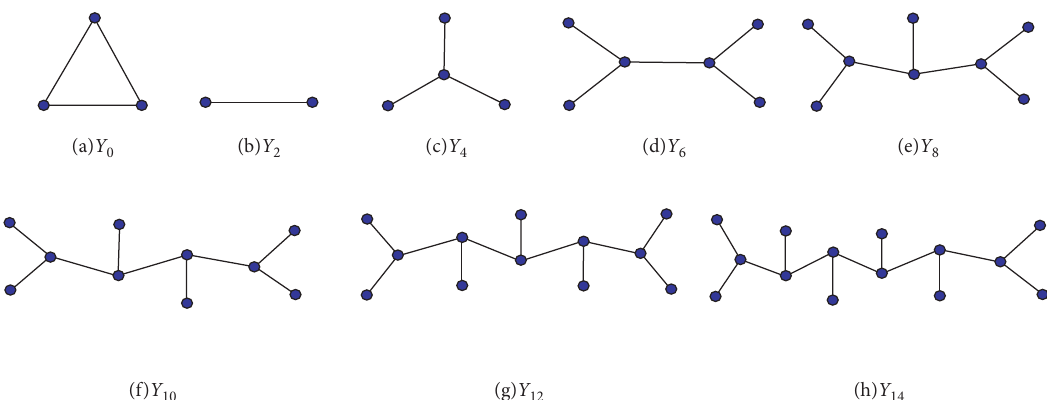
Figure 2: The graphs Y